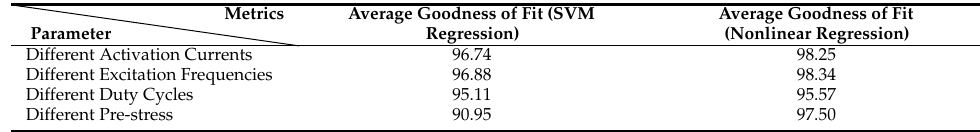
Table 17. Performance of SVR and nonlinear regression model